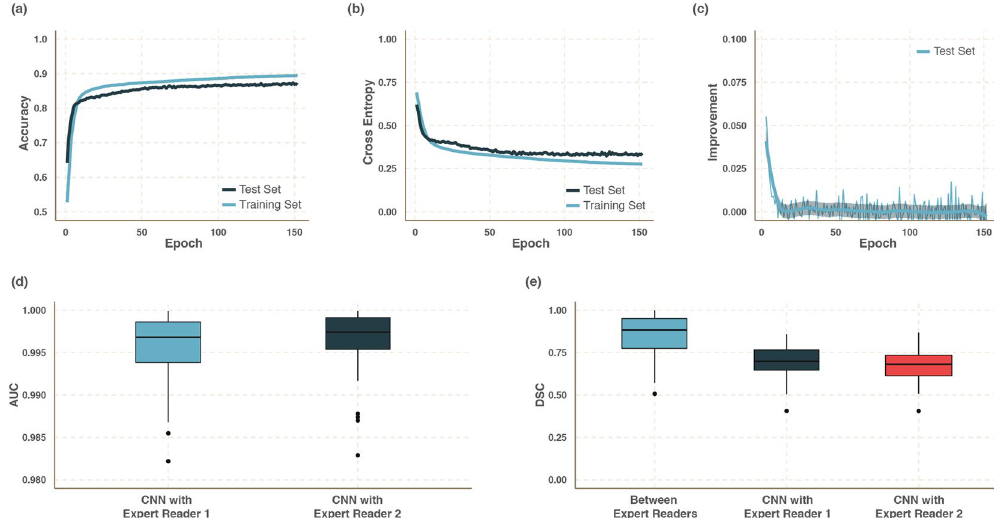
Figure 3. CNN Training and Validation. Performance of the CNN on the discovery dataset: ( a ) accuracy, ( b ) cross entropy and ( c ) improvement ( Δ cross entropy). Improvement shown in panel (c), in computed on the test set only, preventing the model from overfitting. Performance of the CNN on the validation dataset: ( d ) the Area under the ROC curve (AUC) of the probability map with respect to the reader segmentation, and ( e ) Dice Similarity Coefficient (DSC) of the generated